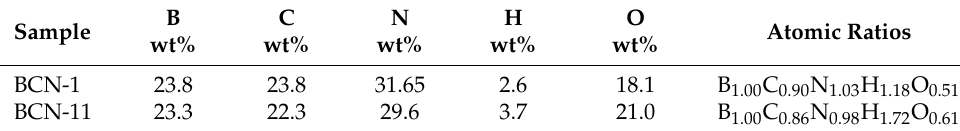
Table 2. Chemical composition and atomic ratios of BCN-1 and BCN-11.